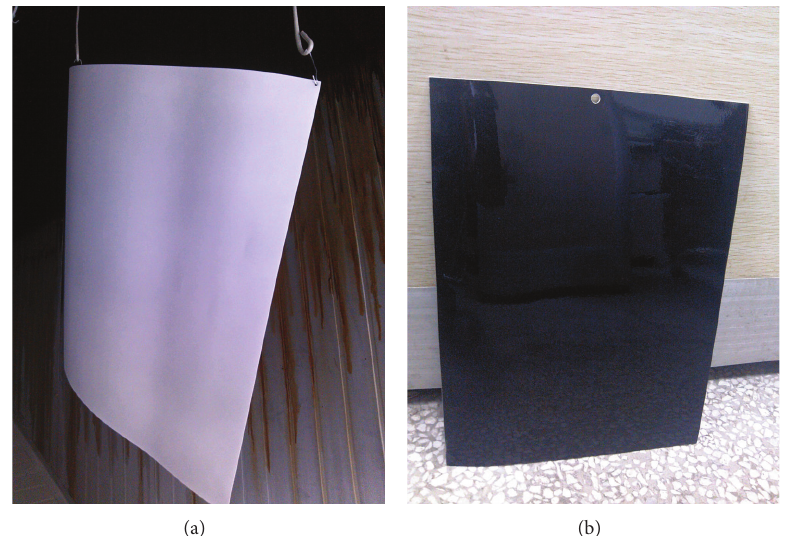
Figure 2: (a) The titanium-based coating surface which was covered by a layer of 30 𝜇 m thick PET powder and before being sent to a constant temperature (200 ∘ C) oven. (b) The TPET surface.